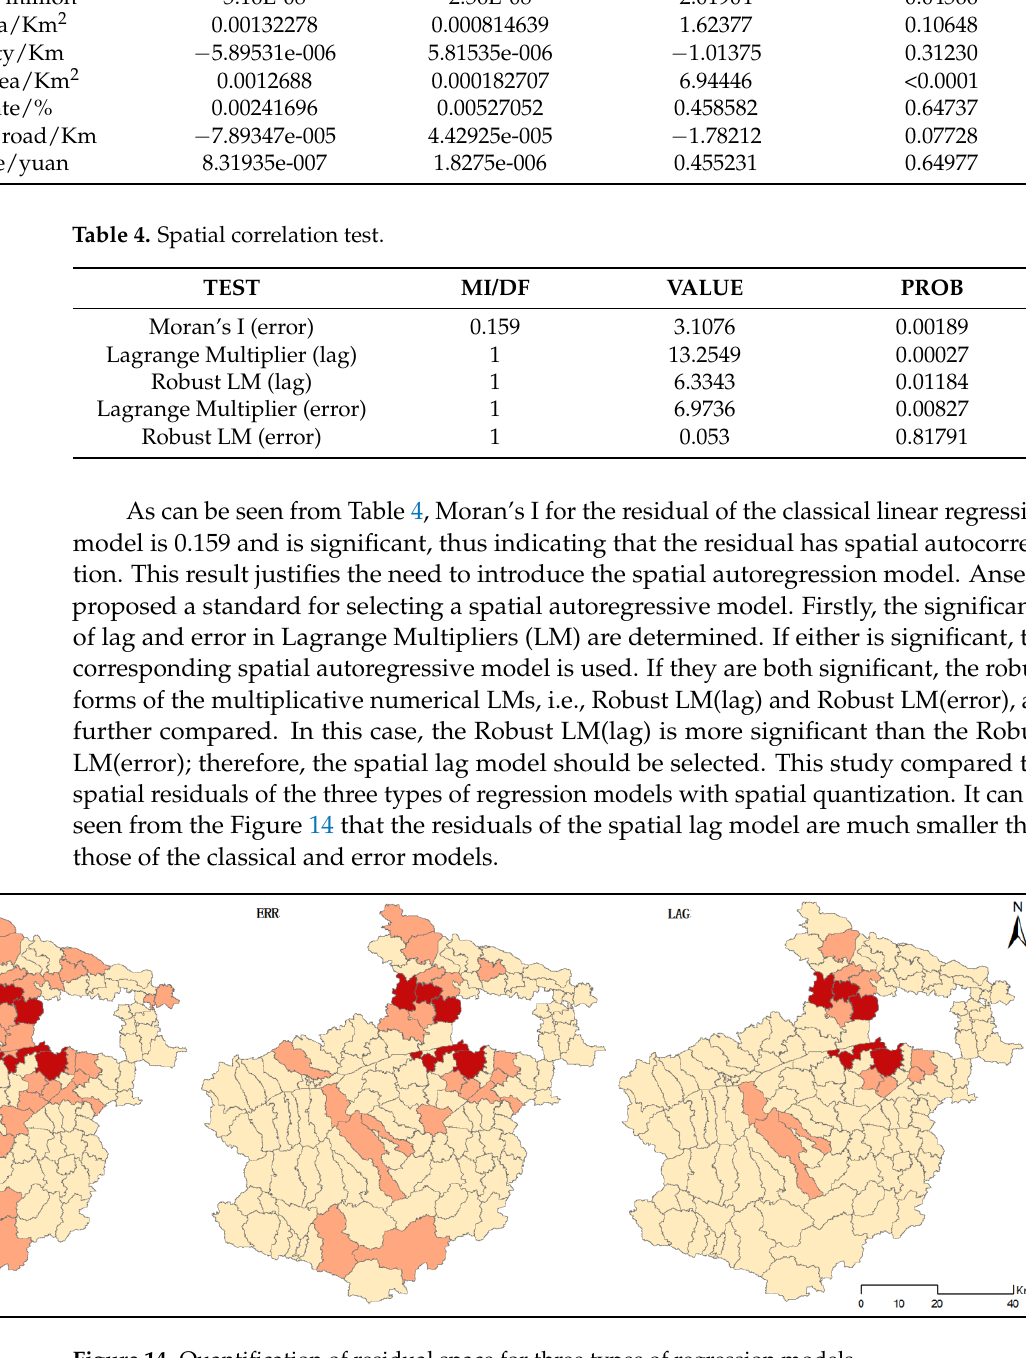
Figure 14. Quantification of residual space for three types of regression models.